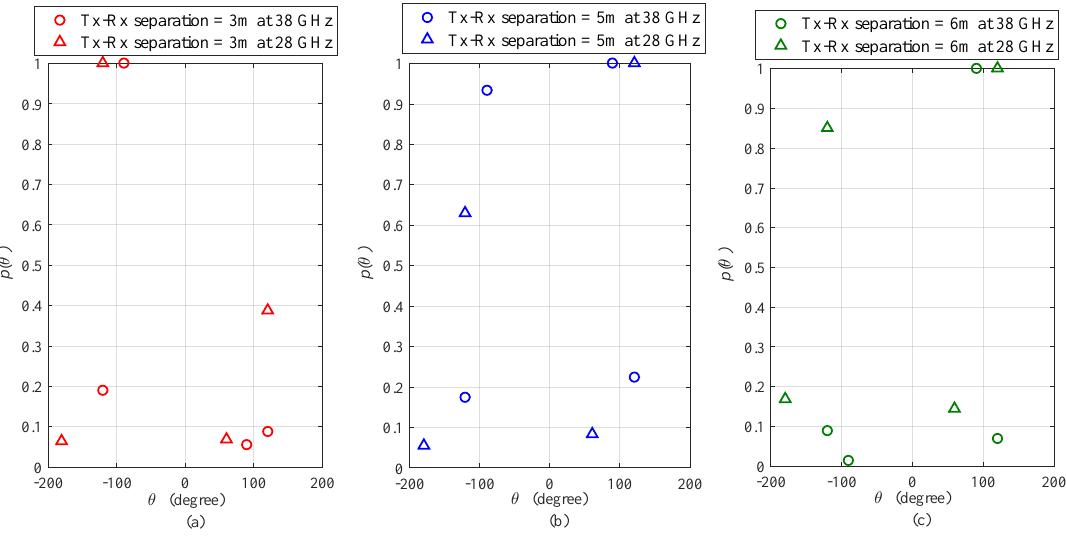
Figure 2. Angular distribution of multipath power with respect to azimuth AoA for different mmWave (38 GHz and 28 GHz) indoor corridor environments; obtained after data calibrations, and normalization operations performed on the measurement results provided in [7]. ( a ) Tx-Rx separation = 3 m; ( b ) Tx-Rx separation = 5 m; ( c ) Tx-Rx separation = 6 m Figure 13 of